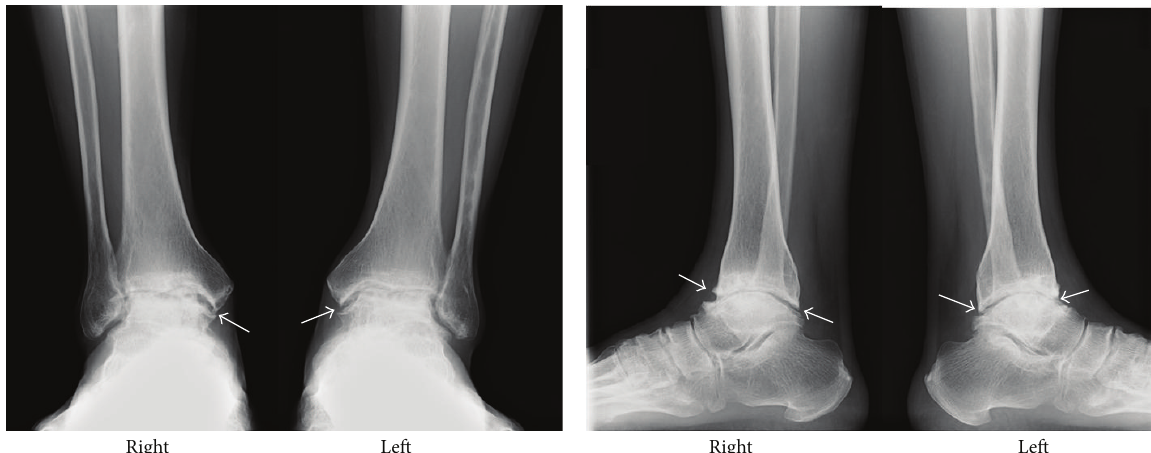
Right Right Left Left Figure 1: Preoperative radiographs of both the ankles. Arrows show osteophytes. Joint spaces are decreased. No pathological changes around the epiphyses plate are observed.